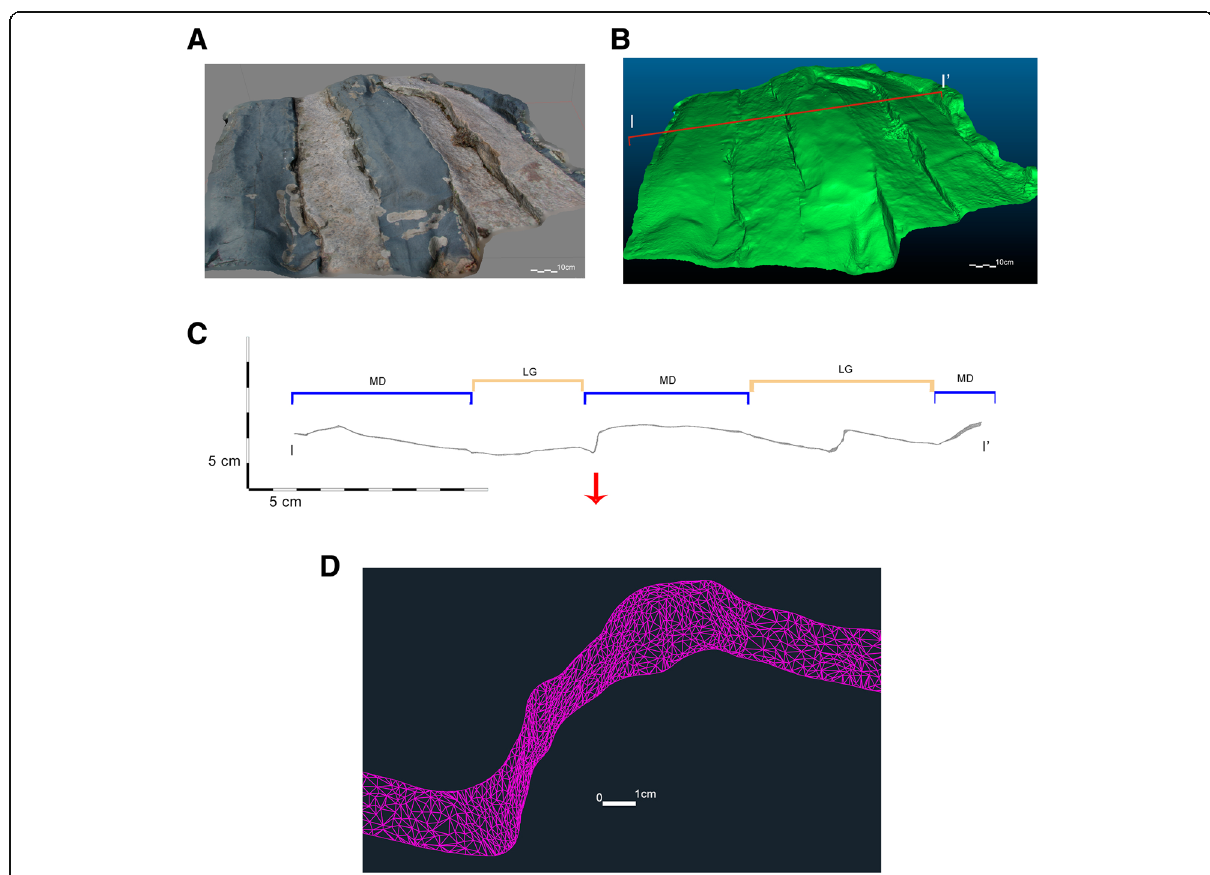
Fig. 9 Textured point cloud 3D model ( a ). Polygonal mesh model of the same area with profile line I-I ′ marked ( b ). I-I ′ profile where Leucogranite (LG) and Microdiorite (MD) areas are marked ( c ). Detail of mesh in the area of the profile marked with an arrow ( d ). Microdiorite dykes run east to west